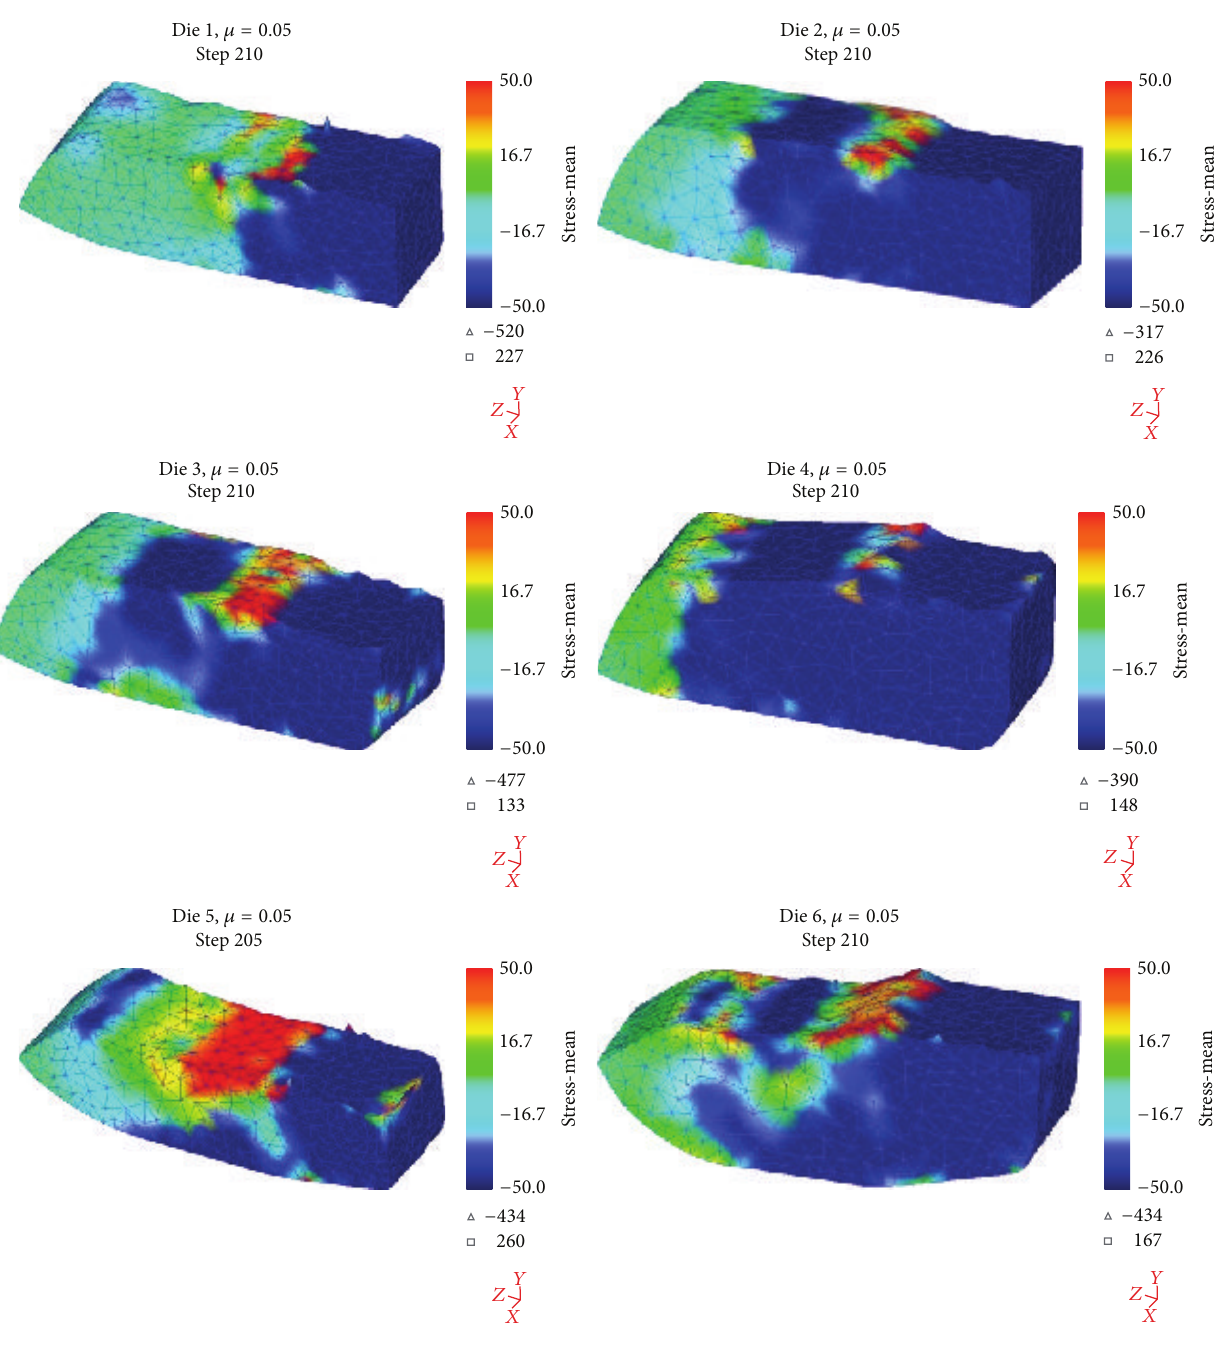
Figure 5: Results of the finite element method simulation showing the tensile stress areas distribution (red area) and compression (blue zone) during the ECAP six configurations of the die’s channel processing as a function of the friction coefficient (𝜇) after one